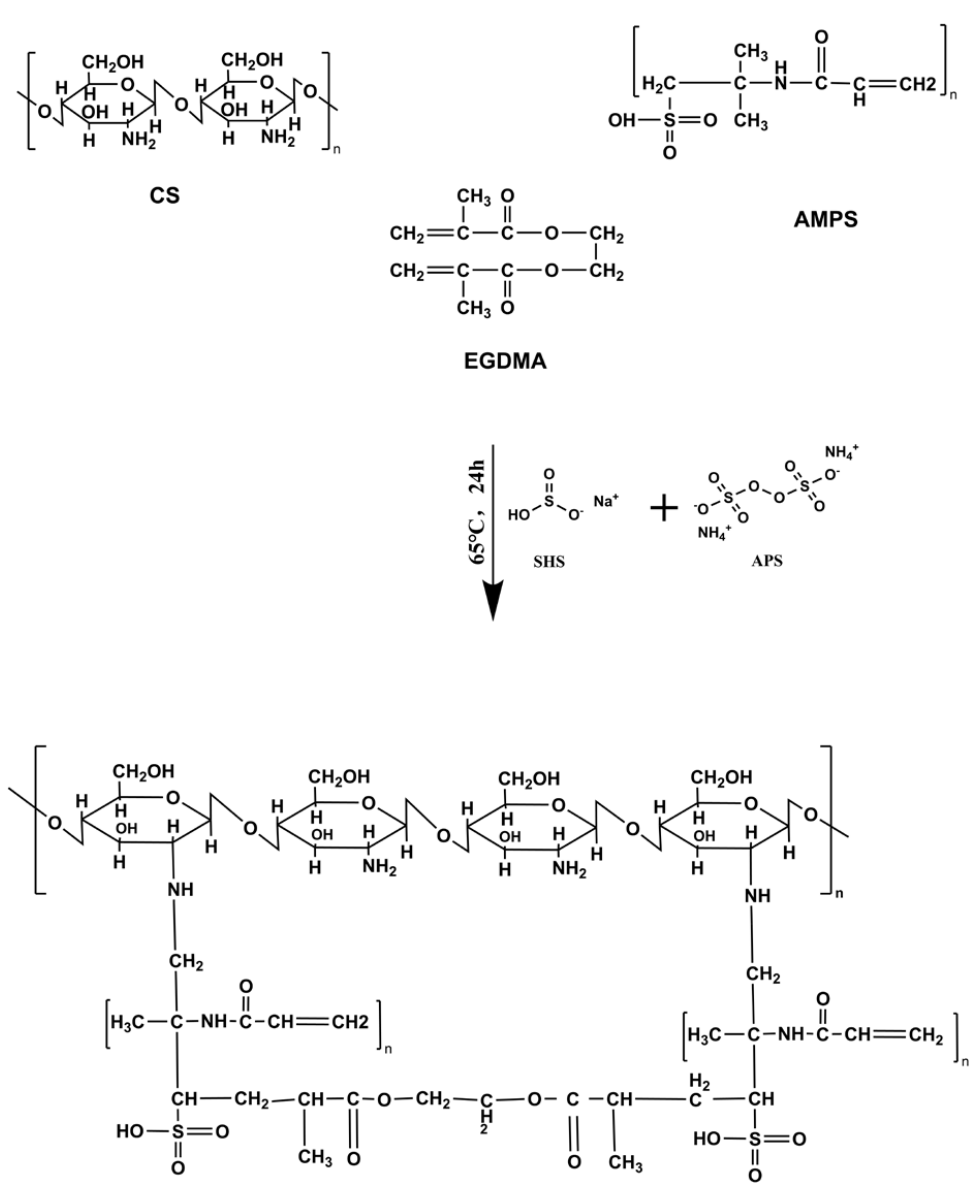
Figure 9. Proposed chemical structure of CS- g -AMPS hydrogels.